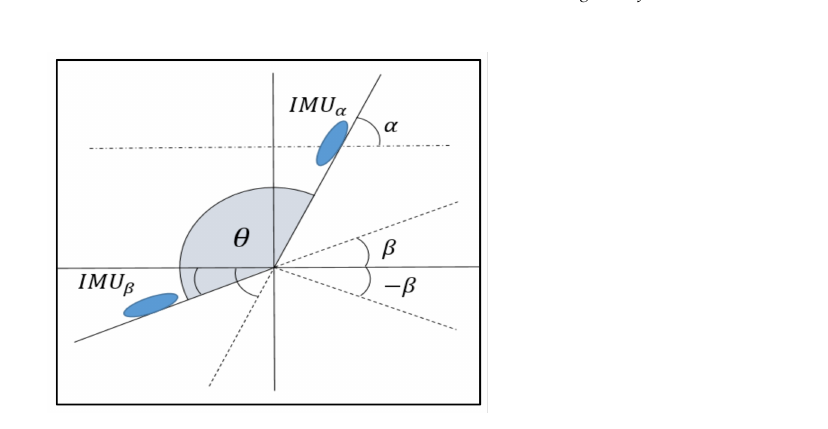
Figure 14. Graphic example to measure the angle formed by two IMUs, θ , through their Euler α and β ‘pitch’